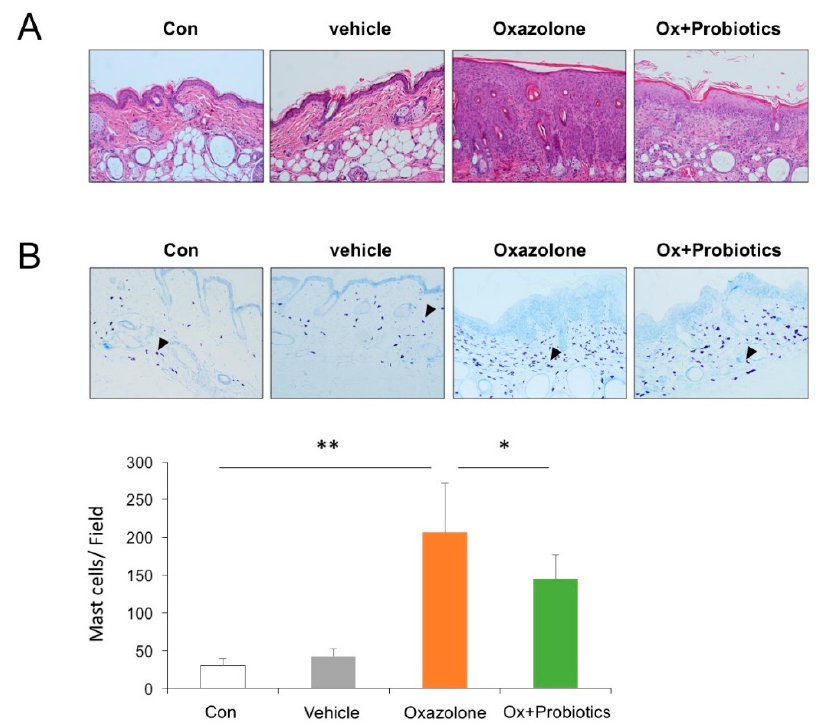
Figure 2. Effects of probiotics on the epidermal skin lesions in Ox-induced AD mice. ( A ) Histological features of epidermal skin lesions. Tissues were fixed in 10% formaldehyde, embedded in paraffin, and sectioned. The sections were stained with H&E (magnification, 400 × ) ( B ) Toluidine blue staining to detect infiltrating mast cells in the dorsal skin of mice. Arrowheads indicates mast cells (magnification, 400 × ). Data pooled from two independent experiments are presented as the mean ± SD. * p < 0.05, ** p < 0.01.